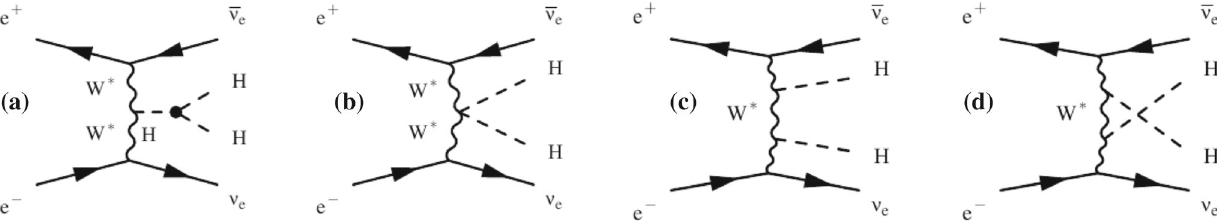
Fig. 2 Main Feynman diagrams contributing to double Higgs boson production via W-boson fusion. Diagram a contains the trilinear Higgs self-coupling, b grows with the quartic coupling g HHWW , while c , d are sensitive to the Higgs coupling to W bosons